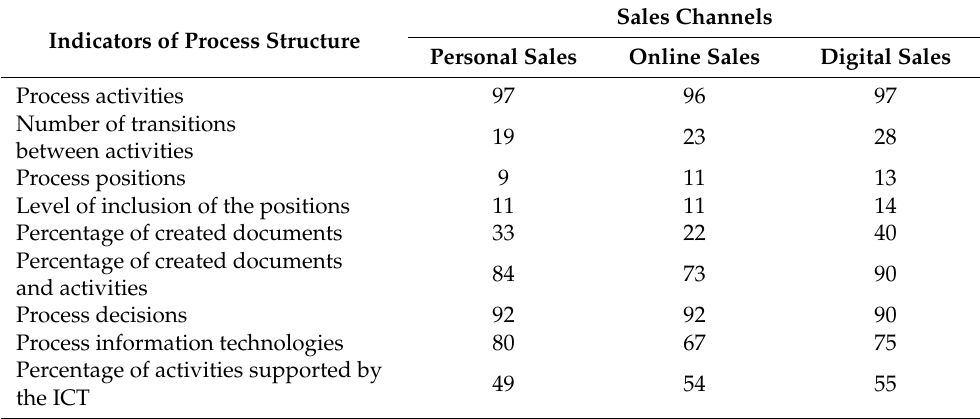
Table 6. Evaluation of sales channel processes according to structural indicators.